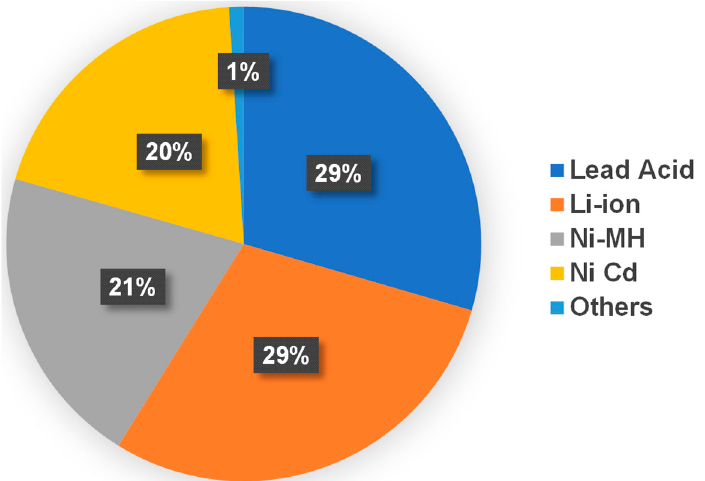
Figure 1. Estimated market share of different batteries in the year 2019 (USD in billions, % market share). Adapted from [16].